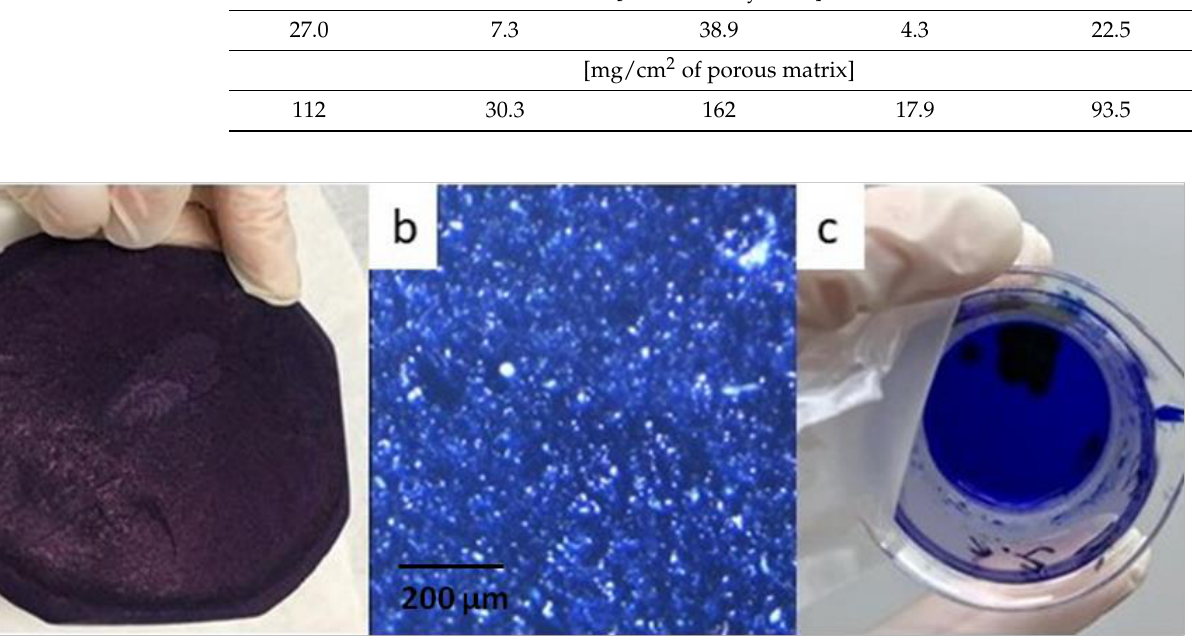
Figure 1. Images of methylene blue-loaded porous matrices ( a ) lower surface (picture taken with Nikon S9300 camera using macro lens); ( b ) microscope view at magnification 10 × cross section (picture taken with MB 200 FL—Opta-Tech (Warsaw, Poland), ( c ) fragment of methylene blue-loaded porous matrix after 90 min of the disintegration test with Canon EOS 77D, Canon 60 mm f/2.8 EF-S USM Macro lens (Canon, Ōta, Tokyo, Japan) with Metz 15 MS-1 ring light (Metz, Markham, ON, Canada).